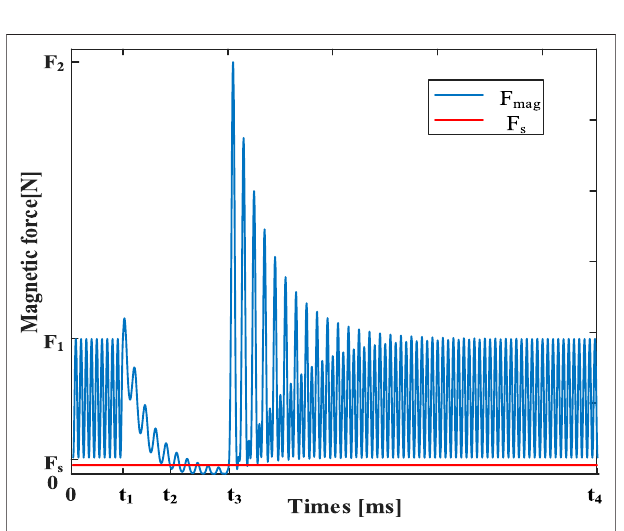
FIGURE3| ThecurvesoftheelectromagneticForce( F mag )andtheforce of spring ( F s ).